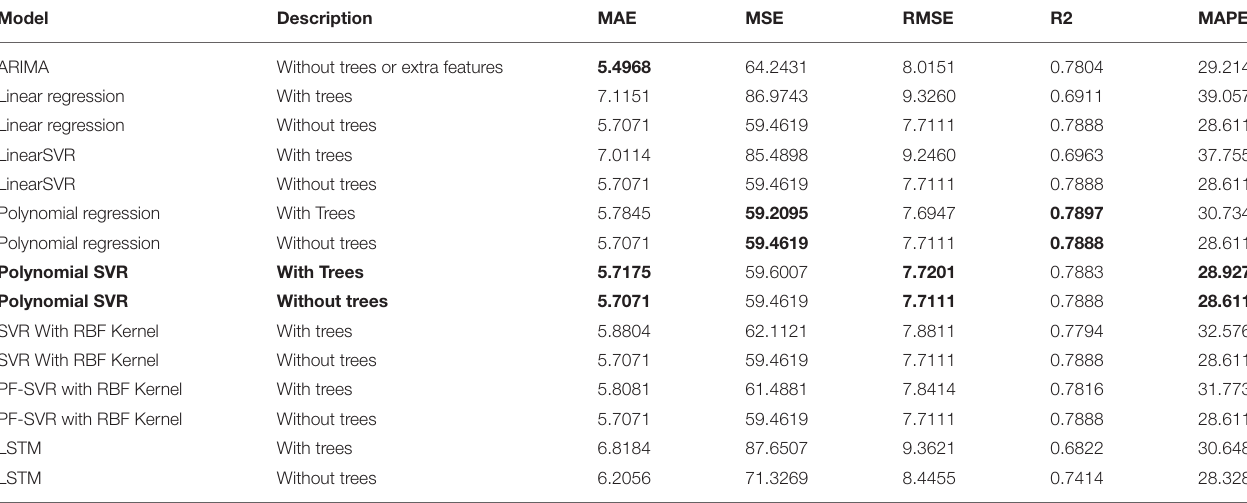
TABLE 6 | Experimental results for NO2, location-1, and Parker Street.